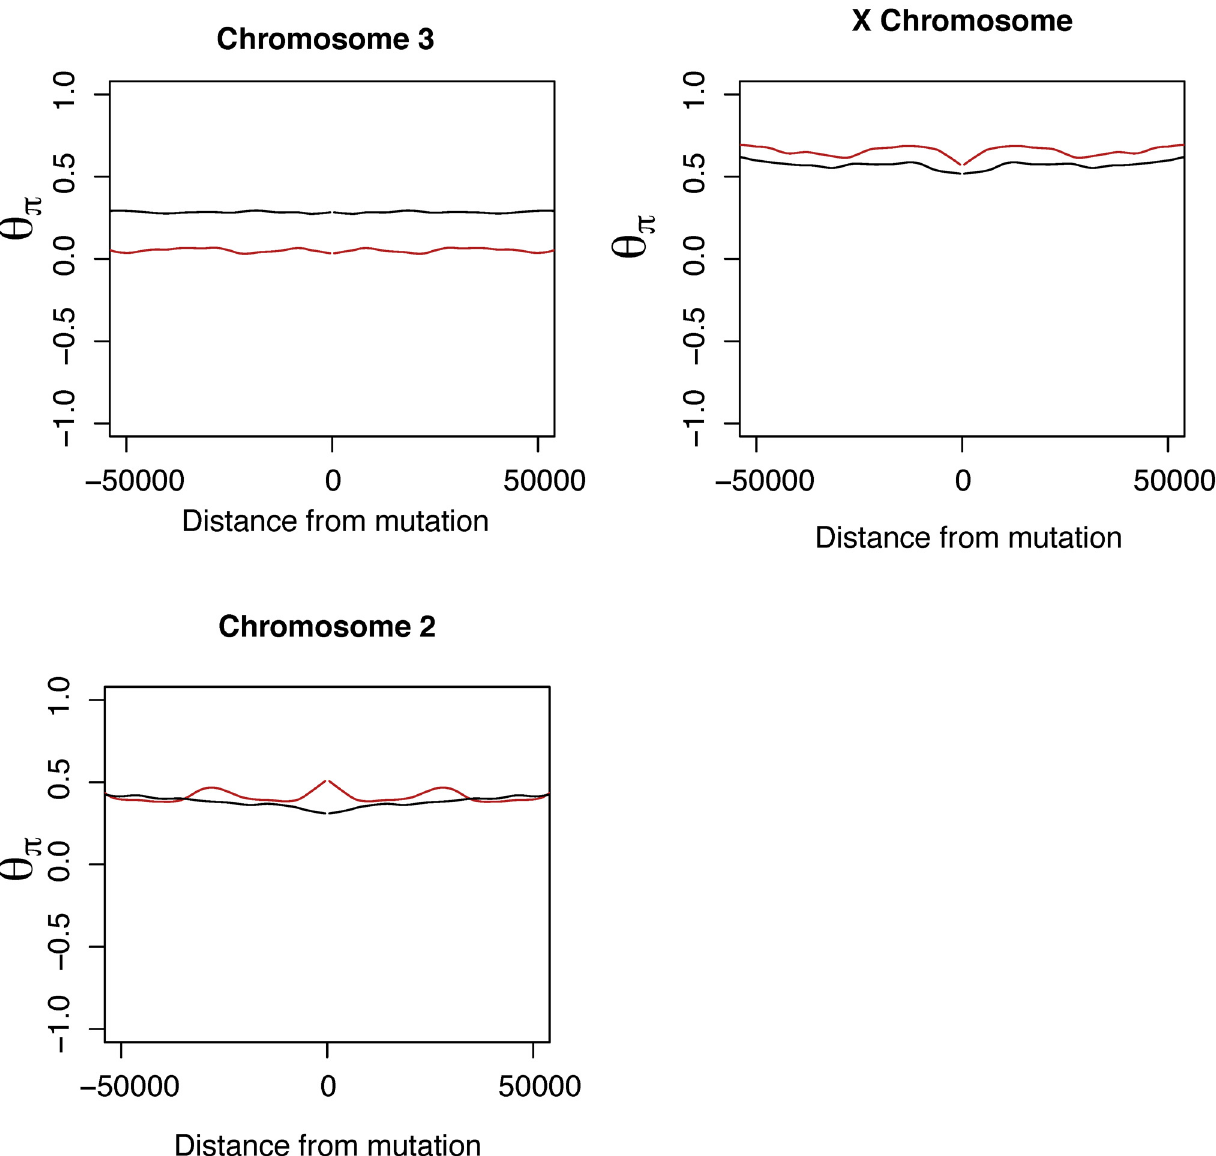
Fig 2. Diversity ( θ π ) as a function of distance from new mutations in D. yakuba for putatively neutral intronic SNPs (black) and for tandem duplications (red) by chromosome with lowess smoothing. Duplicates show a reduction in diversity approaching duplications on chromosome 3L, whereas neutral SNPs show no reduction in diversity. Plots exclude centromeric regions and the 4th chromosome which have atypical nucleotide diversity. D. yakuba chromosome 2 displays an atypical pattern of increased diversity and was handled separately from chromosome 3 due to segregating inversions in